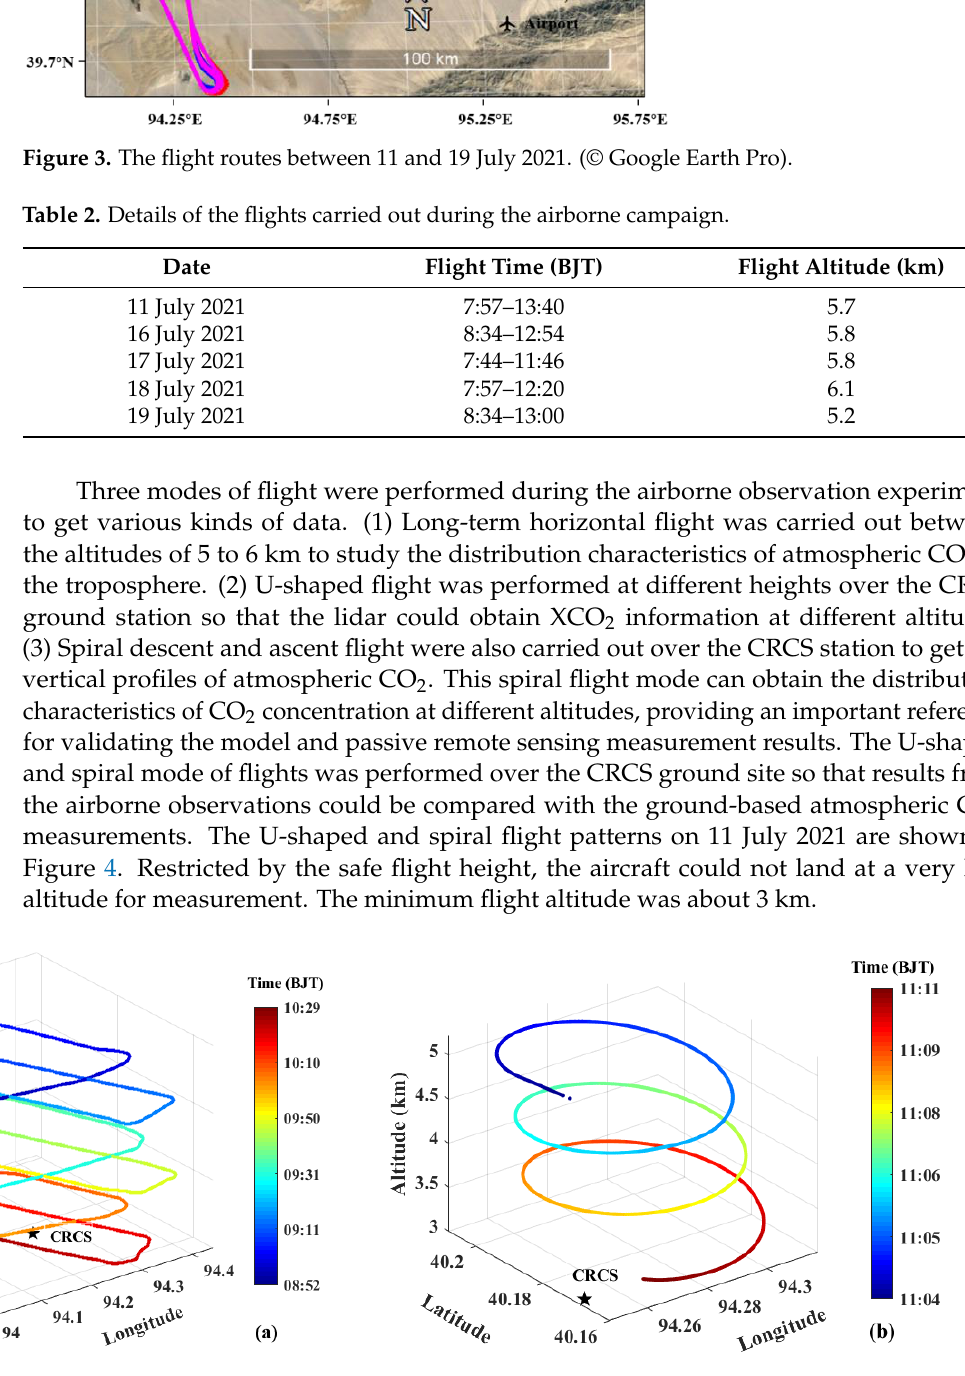
Figure 3. The flight routes between 11 and 19 July 2021. (© Google Earth Pro). Table 2. Details of the flights carried out during the airborne campaign.